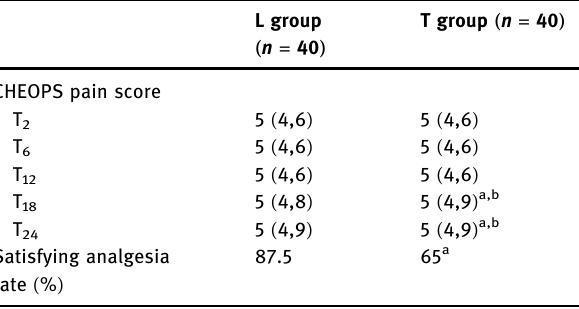
Table 3: Comparison of the analgesic e ff ects in the two groups within 24 h after